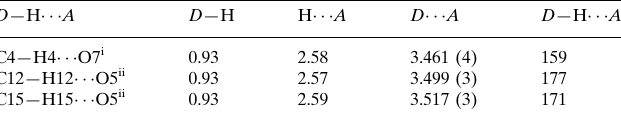
Hydrogen-bond geometry (A˚ , (cid:1)